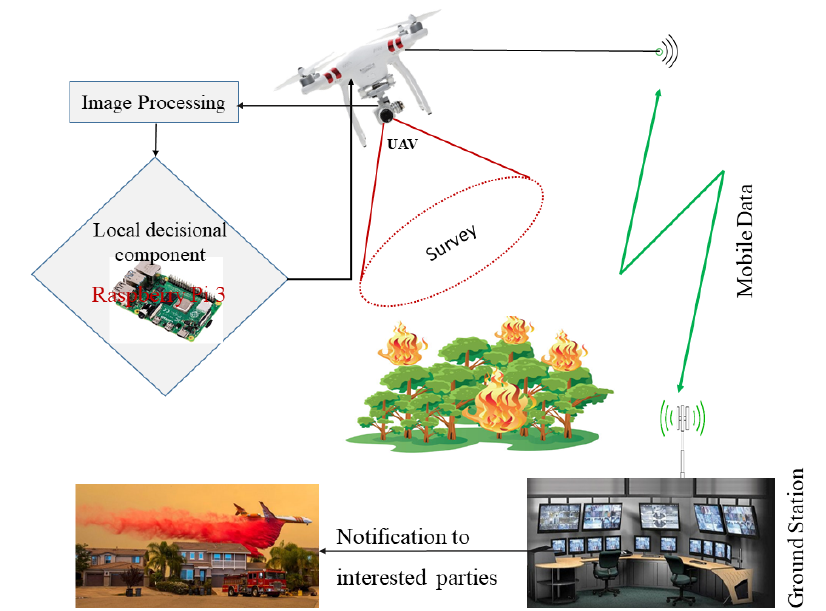
Figure 1. A conceptual model for early forest fire